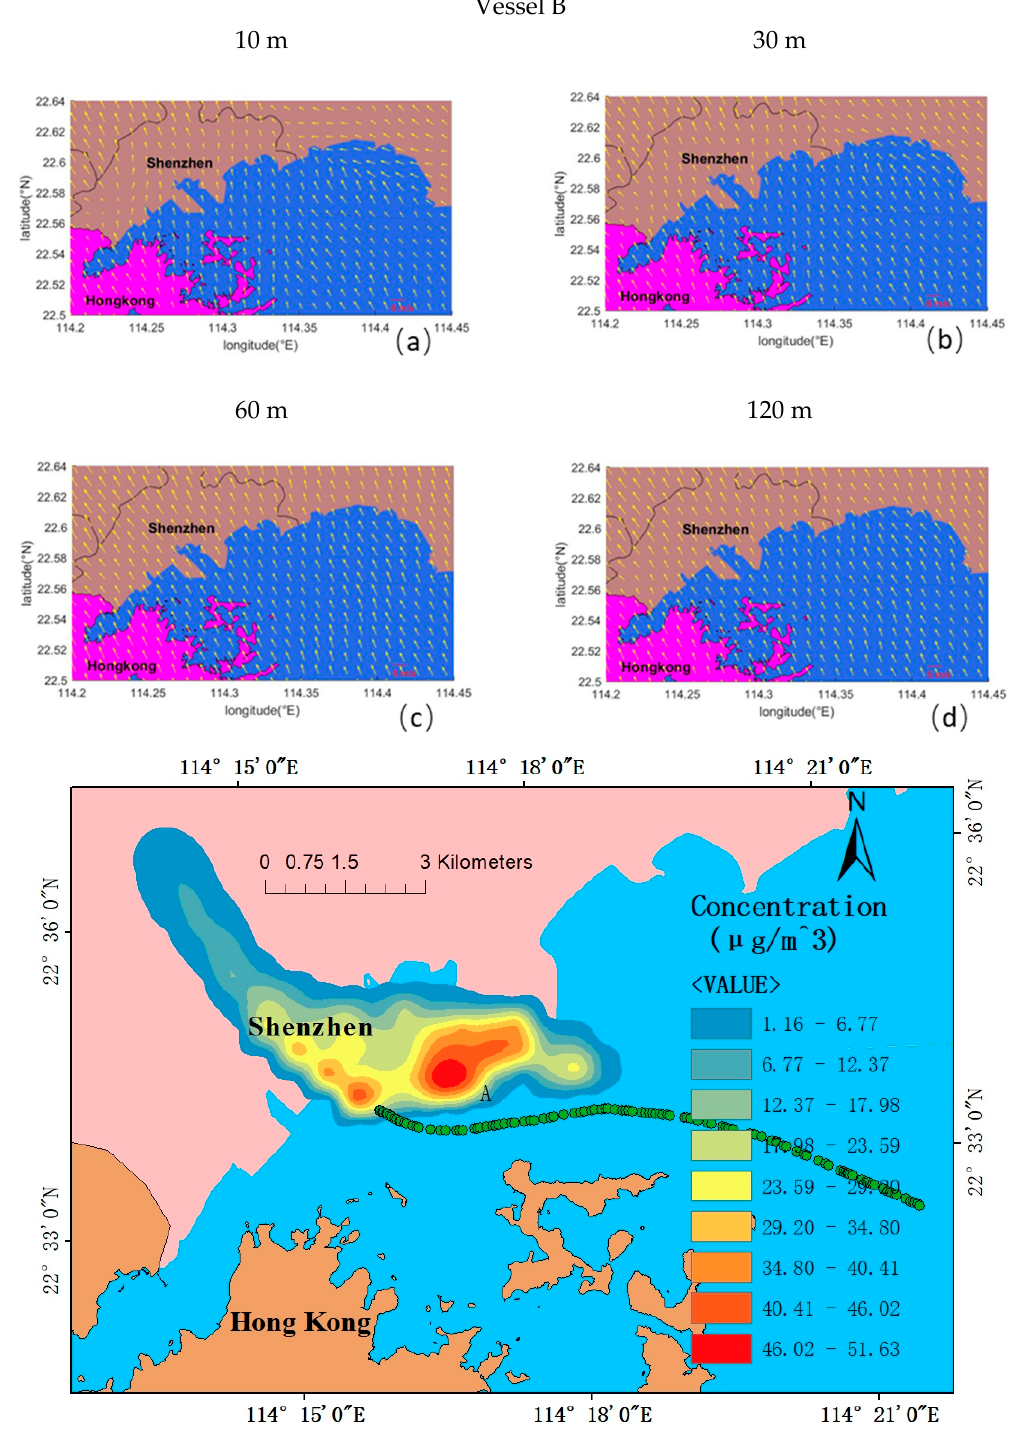
Figure 4. Wind field at di ff erent heights at the departure stage of Vessel B and the spatial distribution of the maximum concentration of each simulation grid during the simulation period. ( a ) 10 m, ( b ) 30 m, ( c ) 60 m and ( d ) 120 m.